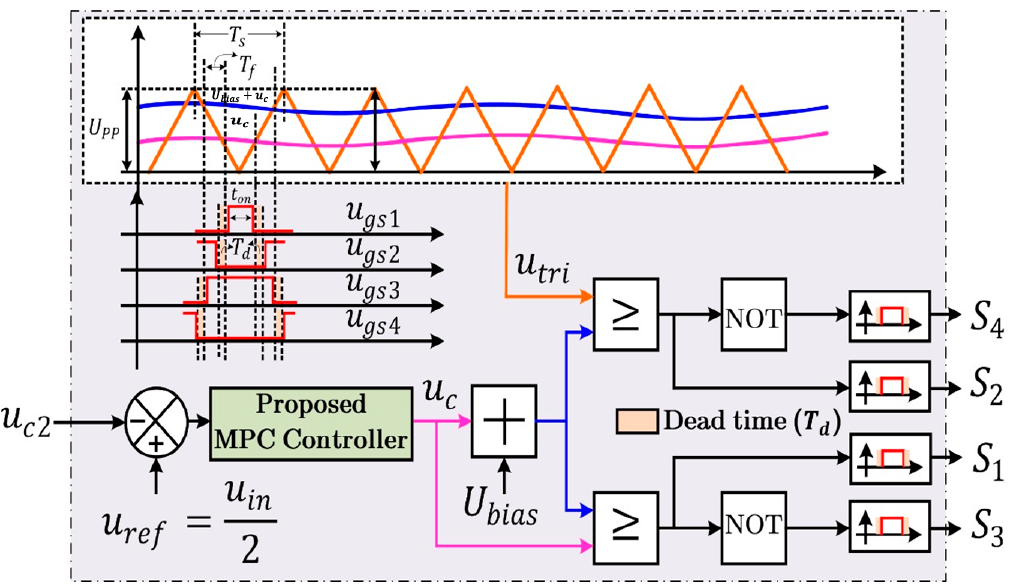
Figure 2. Schematic illustrating the topology of the controller for three-level DC–DC converter.